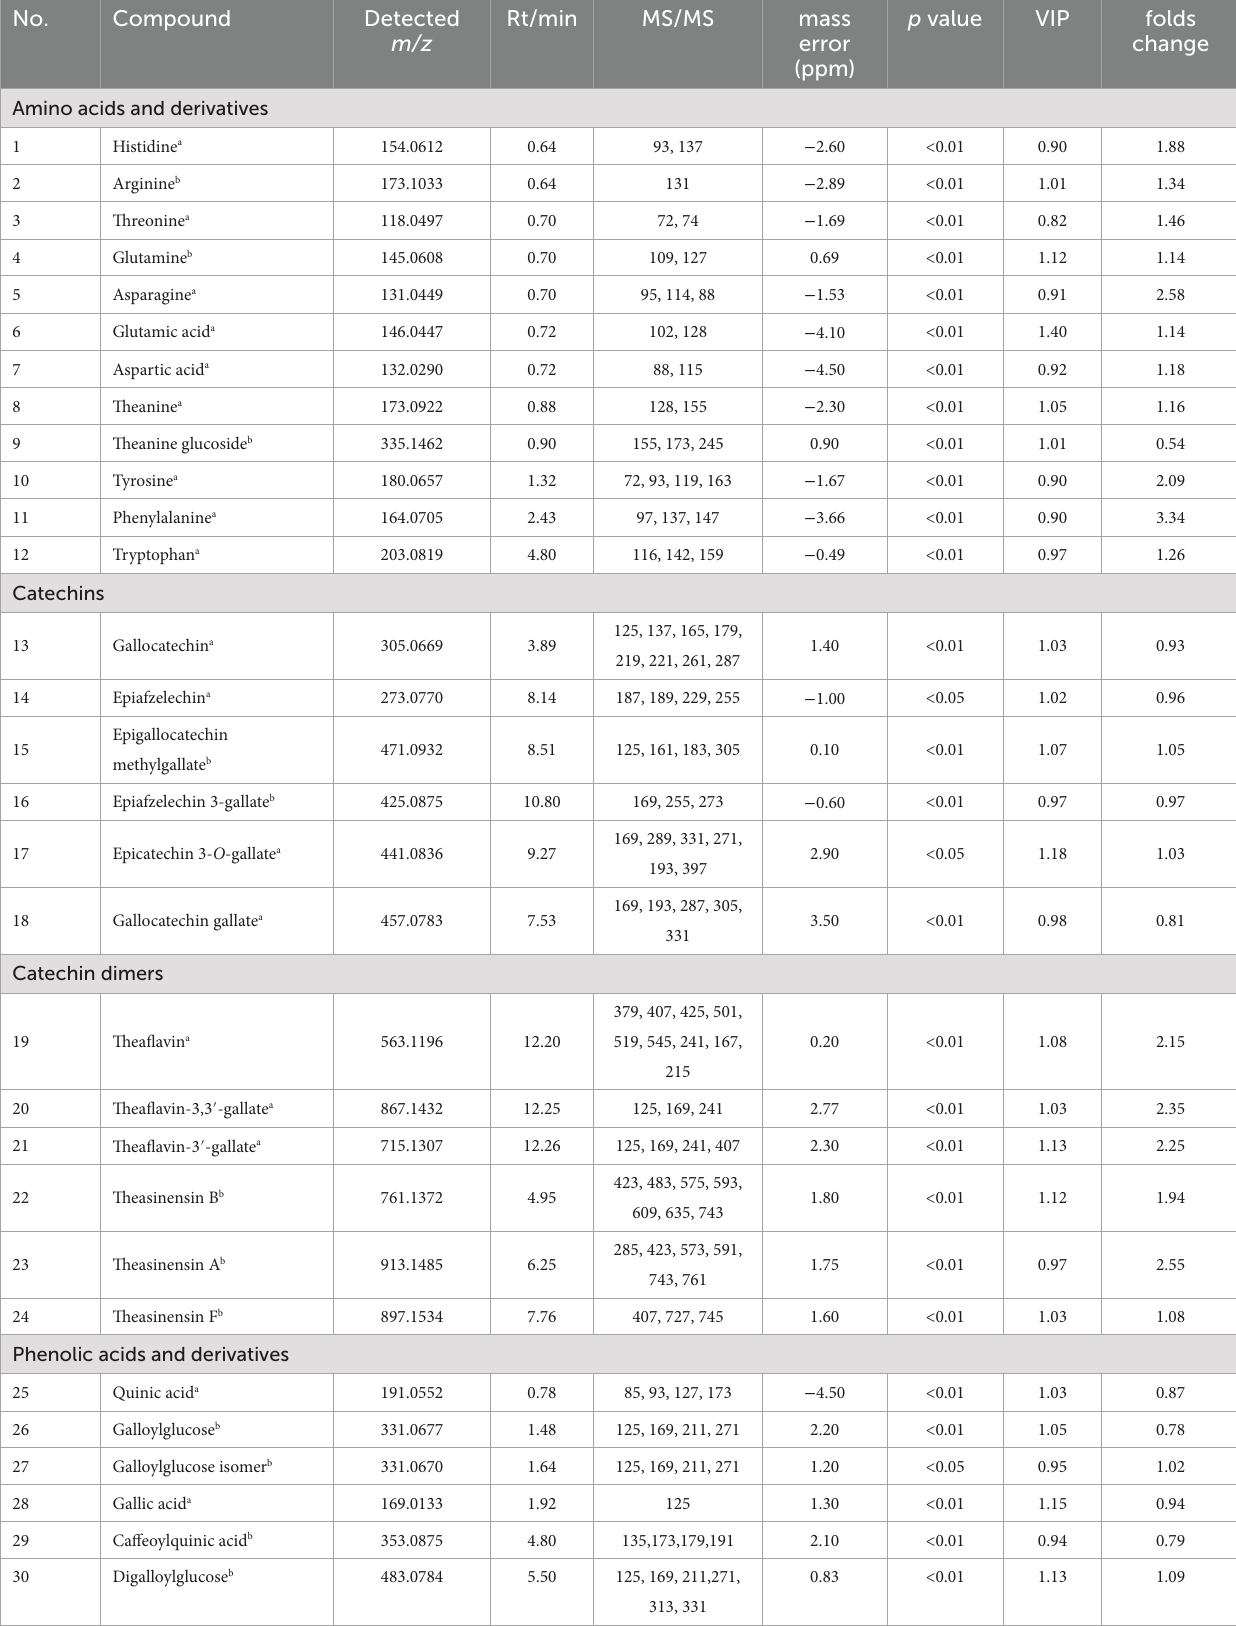
TABLE 2 The detailed information of 69 differential metabolites among Longjing green tea samples treated by different withering degrees, including m/z , Rt, MS/MS fragments, mass error, p value, VIP value of PLS-DA models, and folds change (W5 vs. W1).